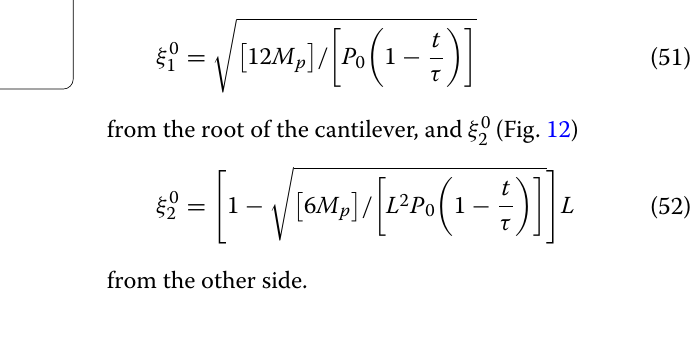
from the other side.